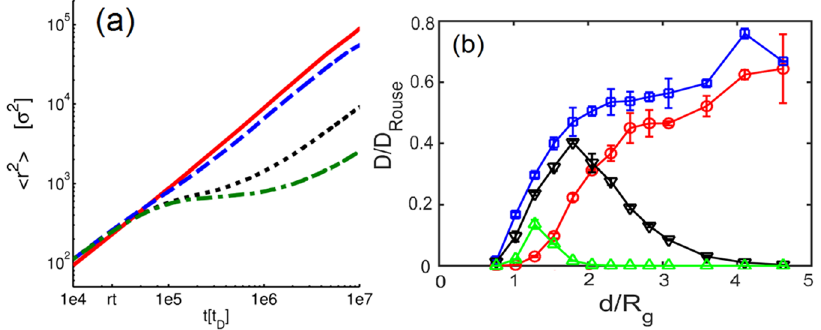
Figure 4. Langevin dynamics results for polymer diffusion in post arrays. ( a ) The polymer COM MSD < r 2 > xz in post arrays of d/R g = 1.8 (solid line), 2.6 (dashed line), 3.6 (dotted-line) and 4.4 (dash-dot line). The data is calculated averaged over a time period of 10 8 t D with 10 trials for each parameter. ( b ) The dependence of model polymer diffusivity D L on d/R g . Chain diffusivity in the post array is normalized by the bulk diffusivity. The symbols denote ε = 0.3 (square), 0.6 (downward triangle), 1.0 (triangle). The circles show the results in a purely repulsive array.